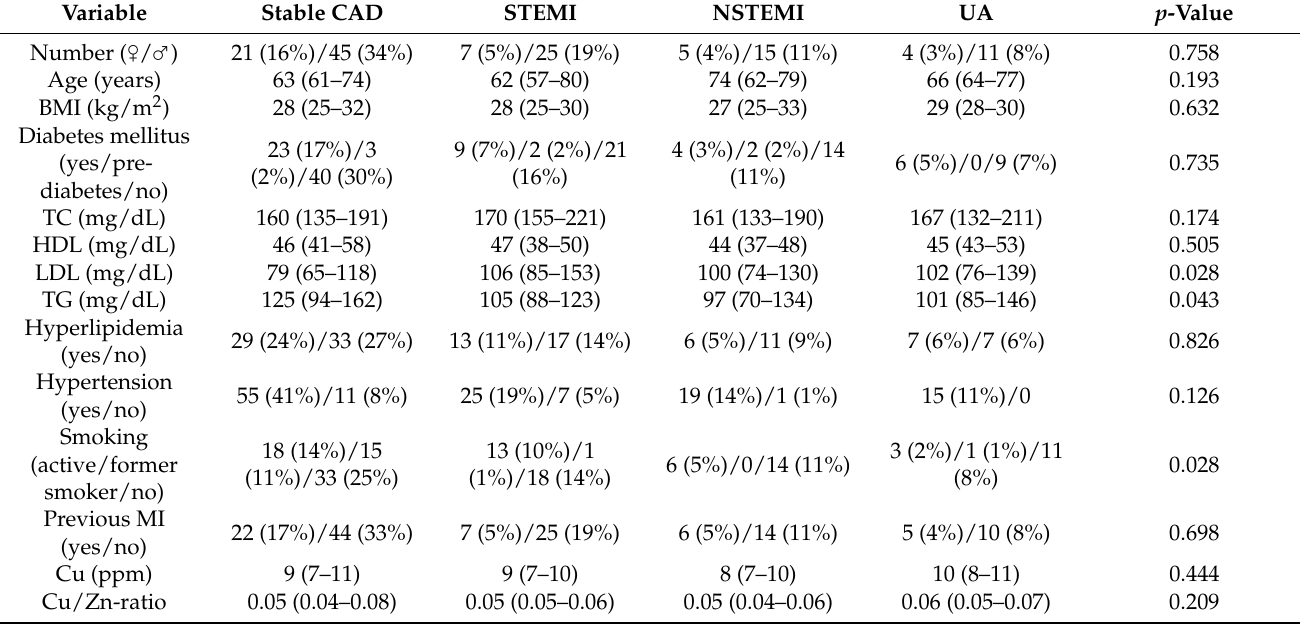
Figure 1. Differences in Cu and Cu/Zn-ratio between male and female, age groups, and BMI groups. 3.2. Differences in Cu and Cu/Zn-Ratio Levels between Patients with ACS and Stable CAD Table 2 presents the results for patients with different diagnosis: stable CAD, STEMI, NSTEMI, UA in measured parameters. Table 2. Differences in selected parameters between patients with different diagnoses.